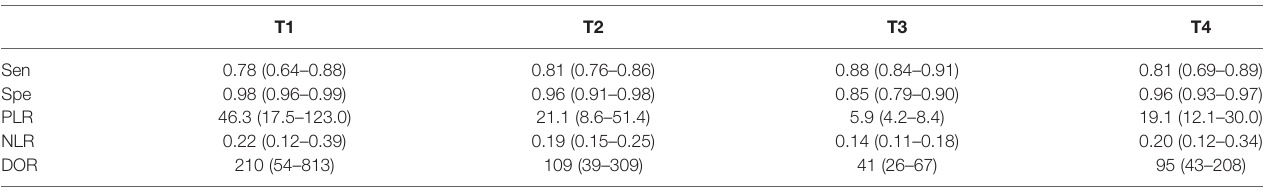
TABLE 2 | Descriptive diagnostic performance of